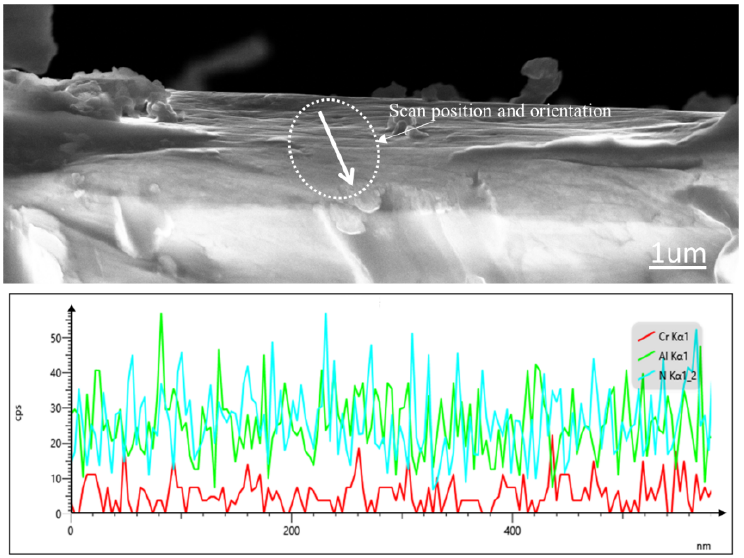
Figure 5. Surface energy spectrum analysis of coatings.